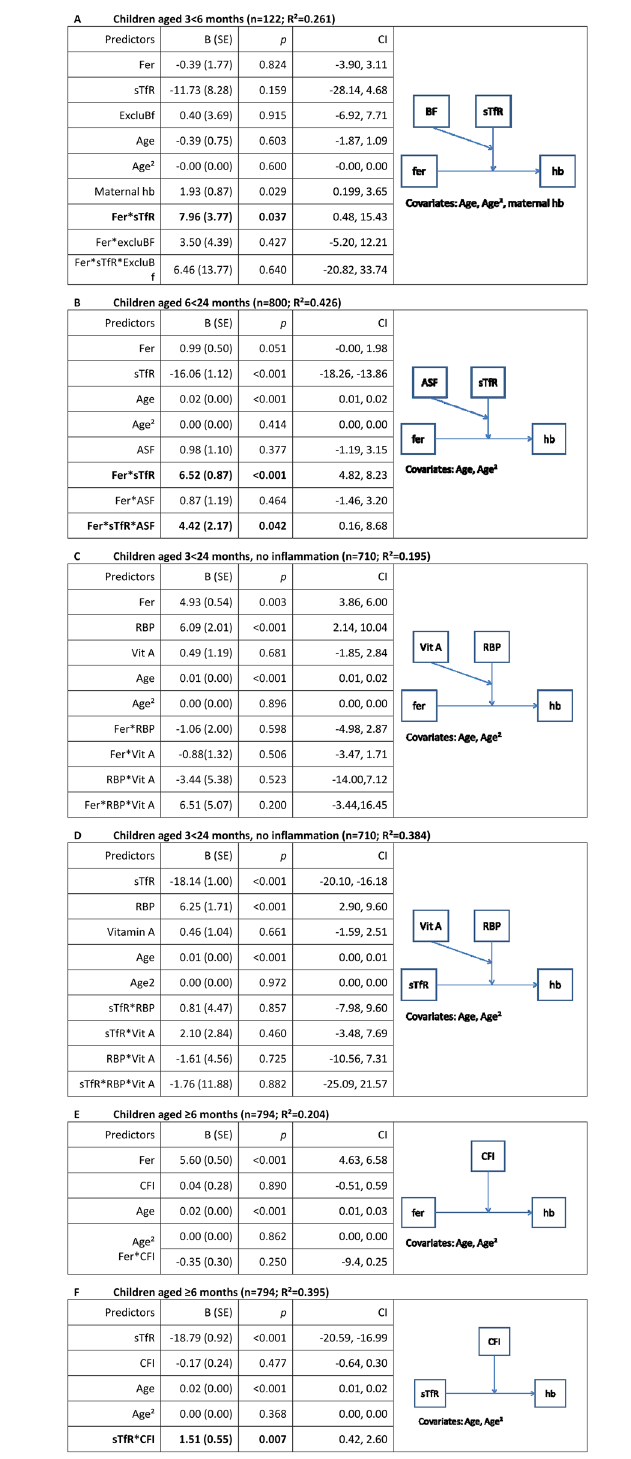
Fig 4. a-f. Results from moderator analyses with hemoglobin as outcome variable. Fer = Ferritin ( μ g/L); sTfR = soluble transferrin receptor (mg/L); ExcluBf = exclusive breastfeeding; hb = maternal hemoglobin (g/ L); RBP = retinol binding protein ( μ mol/L); ASF = animal source foods; Vit A = vitamin A supplement; CFI = child feeding index [15]; Age = age of child (days); Fer and sTfR have been used as logarithmized (natural logarithm) continuous variables; ExcluBf and Vit A is a dichotomous variable 1 = yes, 0 = no; RBP